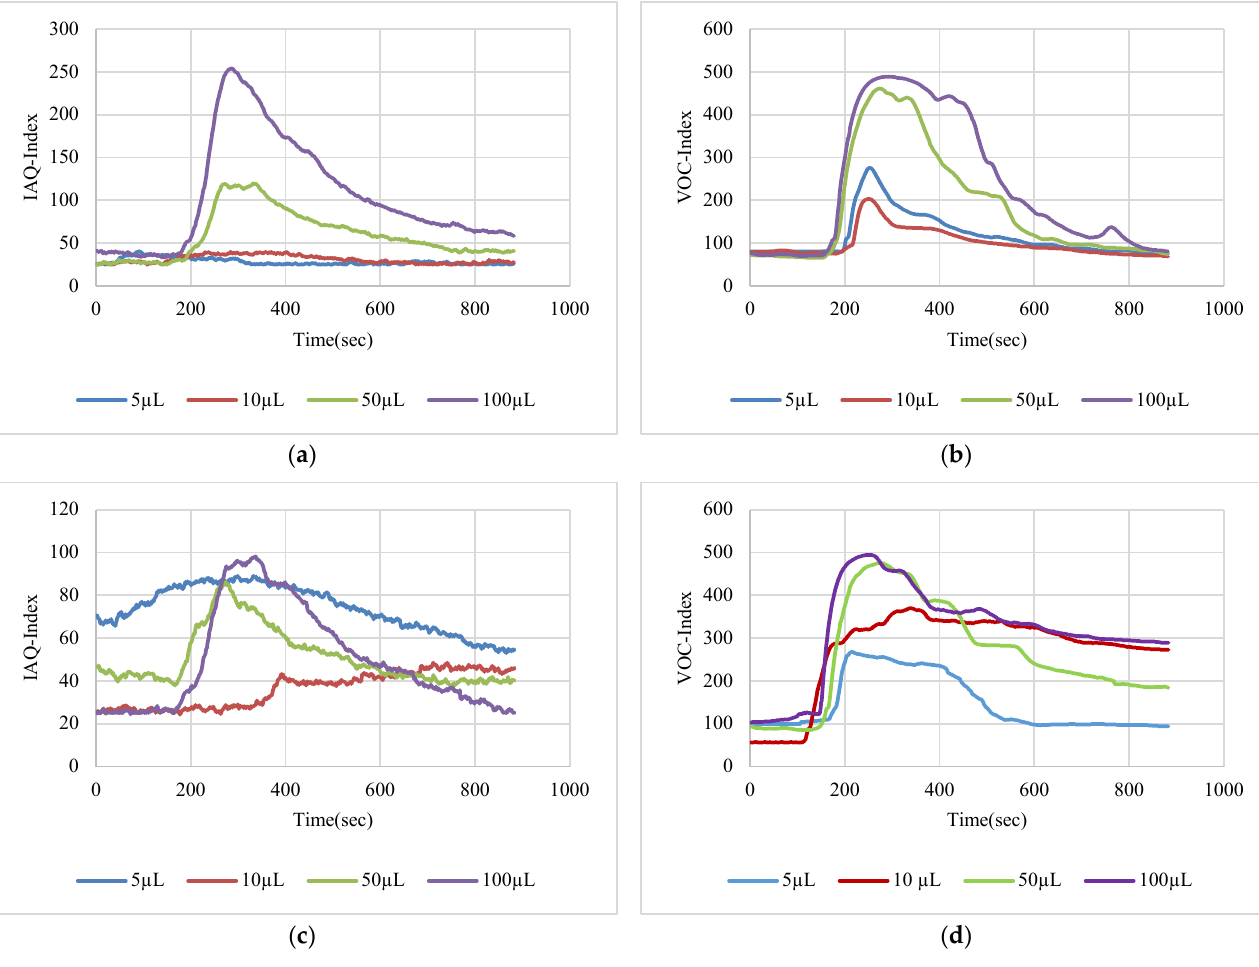
( d ) Figure 15. Test results for ethanol: (a) BME688 40 cm, (b) SGP41 40 cm, (c) BME688 100 cm, (d) SGP41 100 cm.